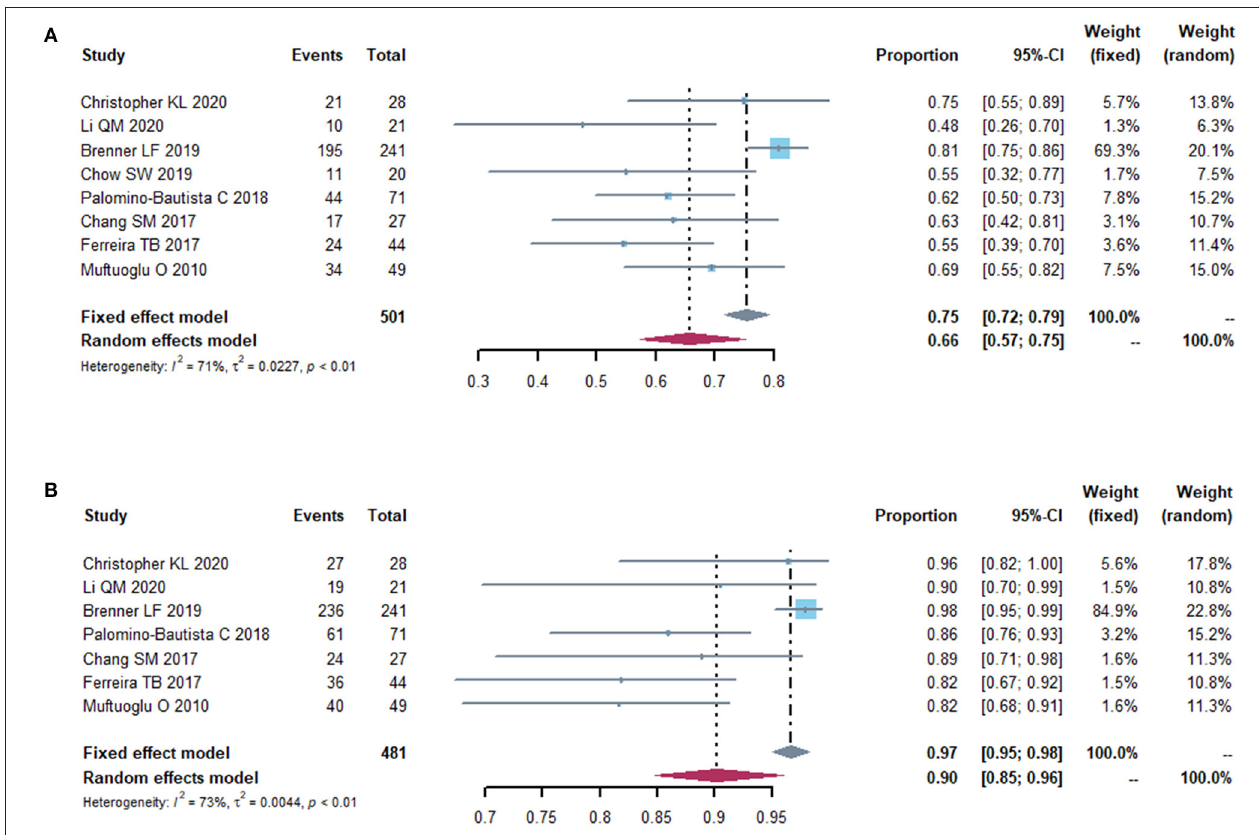
FIGURE 7 | Forest plot of postoperative refraction. The proportion of eyes with a postoperative refraction of 0.5 diopters (A) and 1.0 diopters (B) from the target